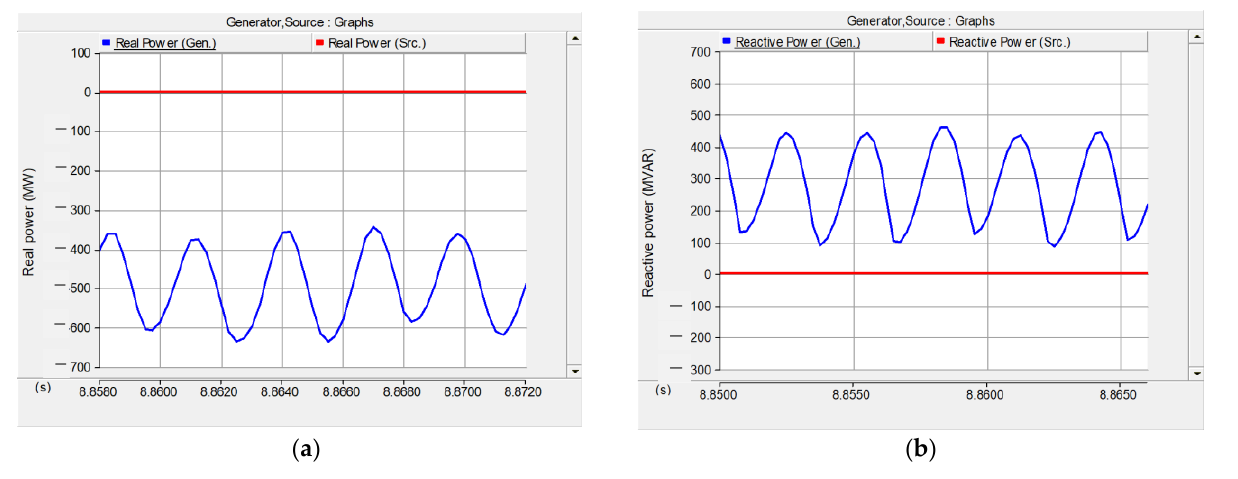
Figure 23. ( a ) Real power; ( b ) reactive power.